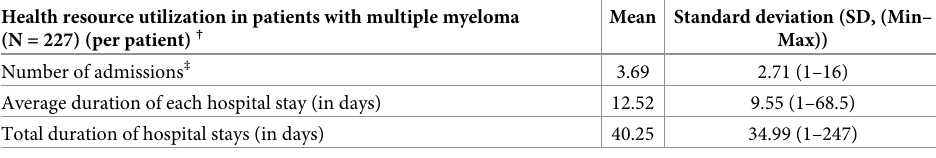
Table 3. Health resource utilization by patients with multiple